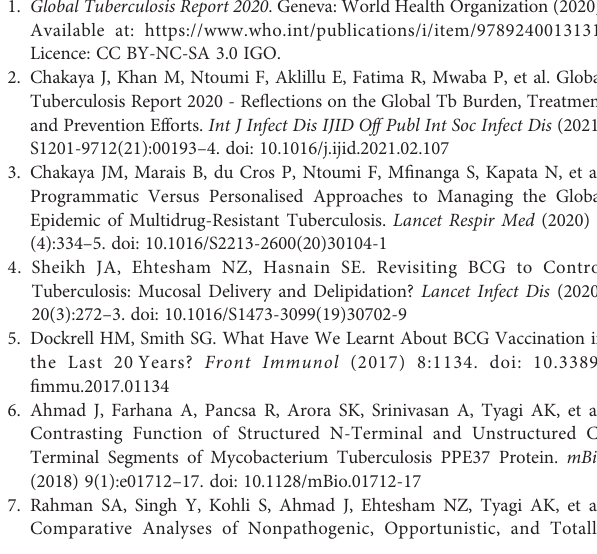
Supplementary Figure 3 | Purity of monocyte derived dendritic cells. Monocytes were isolated from PBMCs after density gradient centrifugation and seeded in 24 wellplates.ThecellsweretreatedwithGM-CSFandIL4tomaturethemtoDendritic Cells. Further cells were collected and stained with CD11c antibody to check the purity of the DCs followed by FACS analysis. (A) The plot shows the purity of monocyte derived dendritic cells. (B) Monocytes treated with GM-CSF and IL4. The red color in panel A symbolizes population negative for CD11c marker. The green color in panel B symbolizes population positive for CD11c marker. (C) RAW 264.7 macrophages were seeded in 96 well (50×10 3 cells/well) followed by treatment with different concentration of Rv1509 protein (1, 2, 4 and 8 m g/ml). MTT was added (10X) to the cells along with media and incubated for 3 hours in dark followed by addition of 200 m l DMSO. The absorbance was taken and percentage of cell death was calculated against untreated cells. The bar graphs represent the cytotoxicity of Rv1509 protein at different concentrations in RAW cells using MTT assay after 48 hrs treatment. Data represents samples plated in triplicates from a representative experiment performed at least three times. Supplementary Figure 4 | (A) The molecular interactions analysis of TLR4 and Rv1509 shows that the protein interacts with several amino acid residues of the binding pocket of TLR2 as shown in the fi gure. (B – D) Secretion of pro in fl ammatory cytokines IL-6, IL-12 and TNF a upon stimulation with Rv1509 protein. Macrophages (RAW264.7, TLR4 knockout and TLR2/4 double knockout)were treated with Rv1509 protein at different concentrations (1, 2 and 4 m g/ml) for 48 hrs. Supernatants were collected and ELISA was performed for determination of IL-6, IL-12 and TNF a levels using BD ELISA kits. No cytokine release is observed from the cells that were genetic mutants for TLR2. Supplementary Figure 5 | Gating strategy for FACS analysis. (A) From the whole cell population lymphocytes were separated based on their size and where these cells were embedded. (B) From the Lymphocyte population CD3 cells were selectedbasedonthe fl uorophoreagainstsidescatteredarea. (C) CD4+andCD8+ cell populations were separated through gating from the total CD3 population and further gating was done for the CD44 and CD62L from individual CD4+ and CD8+ cells. Figures S5A – C represent gating strategy for CD44 and CD62L. (D) For polyfunctional T cell gating we selected whole lymphocyte population from the total cells used for FACS analysis. (E) This fi gure represents the gating of CD4+ and CD8+ cells. From total lymphocyte population CD4+ and CD8+ cells were gated on their respective